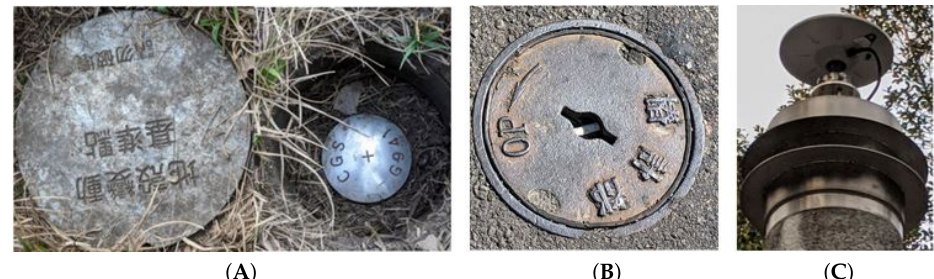
Figure 2. ( A ) Levelling and ( B ) geodetic benchmark in Taichung city, Taiwan and ( C ) a GPS antenna in Puli City, Taiwan. [Photo credit: Marine Roger].